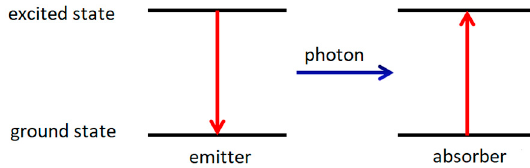
Figure 1. Schematic illustration of emission and subsequent resonant absorption of a light photon.